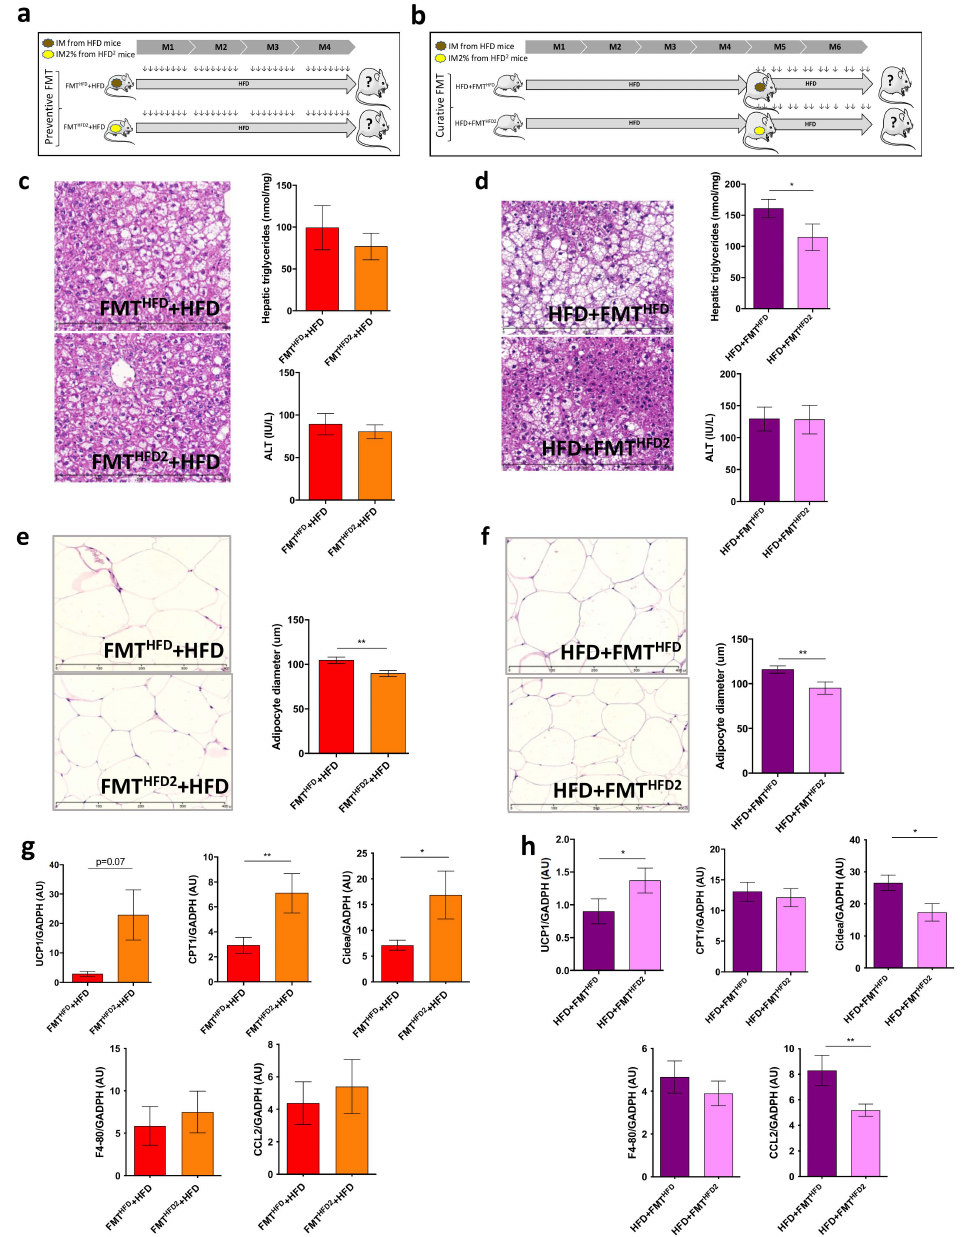
Figure 5. FMT from mice fed an HFD with pectin is sufficient to induce WAT browning in recipient HFD-fed mice: ( a ) experimental setup showing the preventive fecal microbiota transplantation (FMT). Mice received FMT from donor mice fed an HFD (FMT HFD + HFD) or donor mice fed an HFD 2 (FMT HFD2 + HFD). Preventive FMTs were performed twice a week during the 16 weeks of the HFD. ( b ) Experimental setup showing the curative FMT performed after 16 weeks of an HFD and twice a week during eight supplementary weeks of an HFD. Obese mice received a curative FMT before eight supplementary weeks of an HFD from donor mice fed an HFD (HFD + FMT HFD ) or donor mice fed an HFD 2 (HFD + FMT HFD2 ). ( c , d ) Histological images of a liver tissue section stained with hematoxylin-eosin (scale 400 µ m) and hepatic triglyceride content. ( e , f ) White adipose tissue (WAT) section stained with hematoxylin-eosin (scale 400 µ m) and histomorphometric analysis of adipocyte diameter ( µ m). ( g , h ) Quantification of mRNA expression in WAT by RT-qPCR. Data represent the mean ± SEM of 8 or 12 mice. * p < 0.05, ** p <